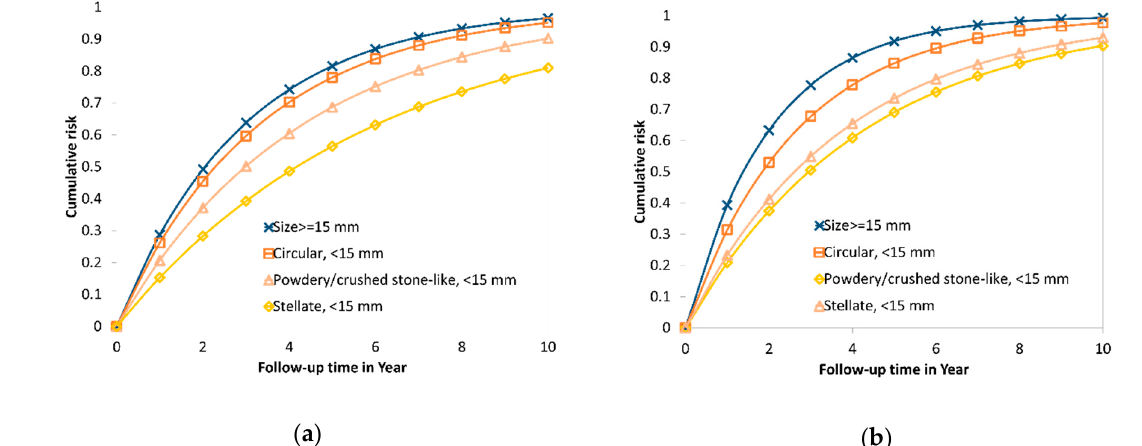
Figure 3. Cumulative risk from PCDP to CP without early detection for three types of mammographic appearance with tumor size < 15 mm and ≥ 15 mm among AAB breast tumor in the two periods.